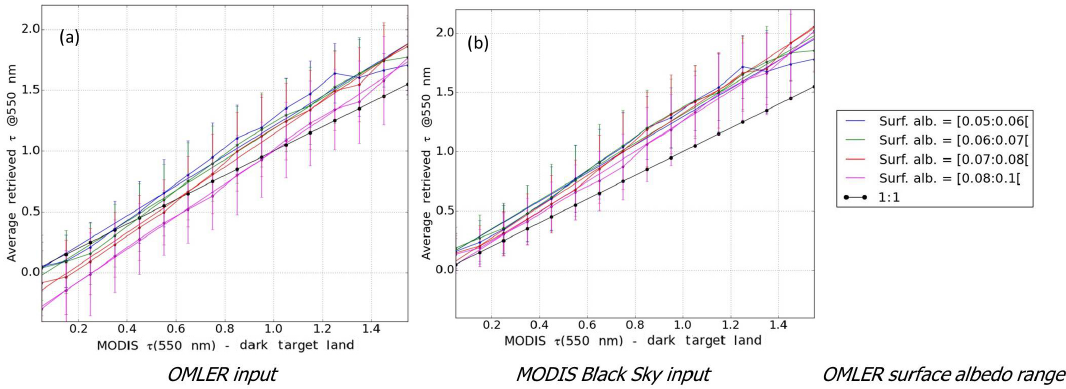
Figure 11. Collocated retrieved OMI retrieval and MODIS Aqua τ( 550nm ) from Dark Target algorithm over land, over north-east Asia for cloud-free scenes in autumn. Retrievals are depicted as a function of OMLER surface albedo ranges (Kleipool et al., 2008; see Sect. 5.1). The dotted black line is the reference 1 : 1. Statistics are computed over 3 years, 2005–2007: (a) OMI retrievals based on OMLER; (b) OMI retrievals based on MODIS black-sky surface